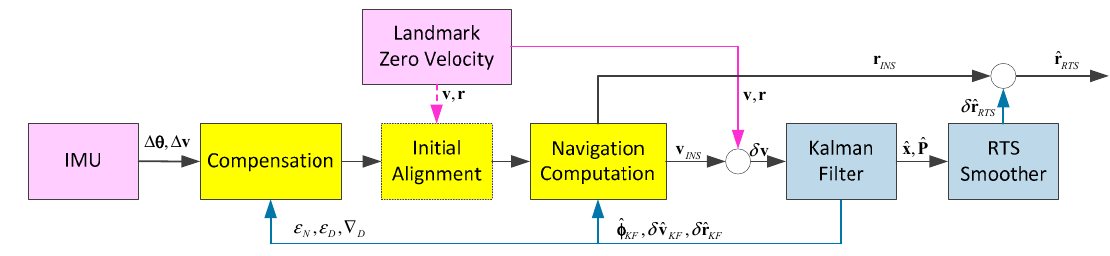
Figure 4. Block diagram of the filtering and smoothing algorithm.